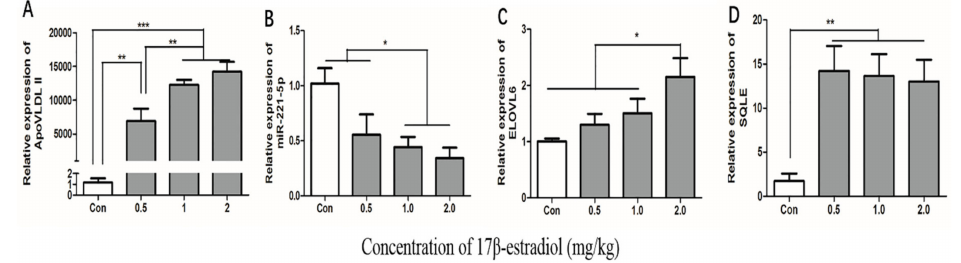
Figure 9. E ff ects of estrogen on the expression of ApoVLDL II , gga-miR-221-5p, ELOVL6, and SQLE gene in vivo. Con indicates control group. β -actin was used as an internal reference gene. U6 was used as an internal reference gene to estimate the relative expression of miRNA. Data are represented as mean ± SD ( n = 8). * means 0.01 < p < 0.05, ** means 0.001 < p < 0.01, *** means p <